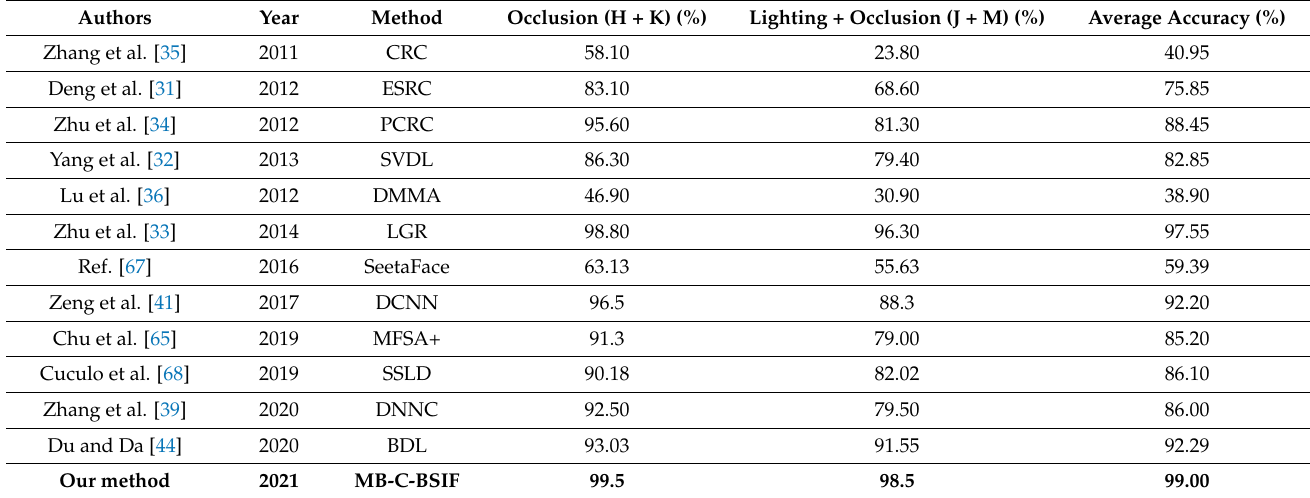
Table 14. Comparison of 12 methods on occlusion and lighting-occlusion